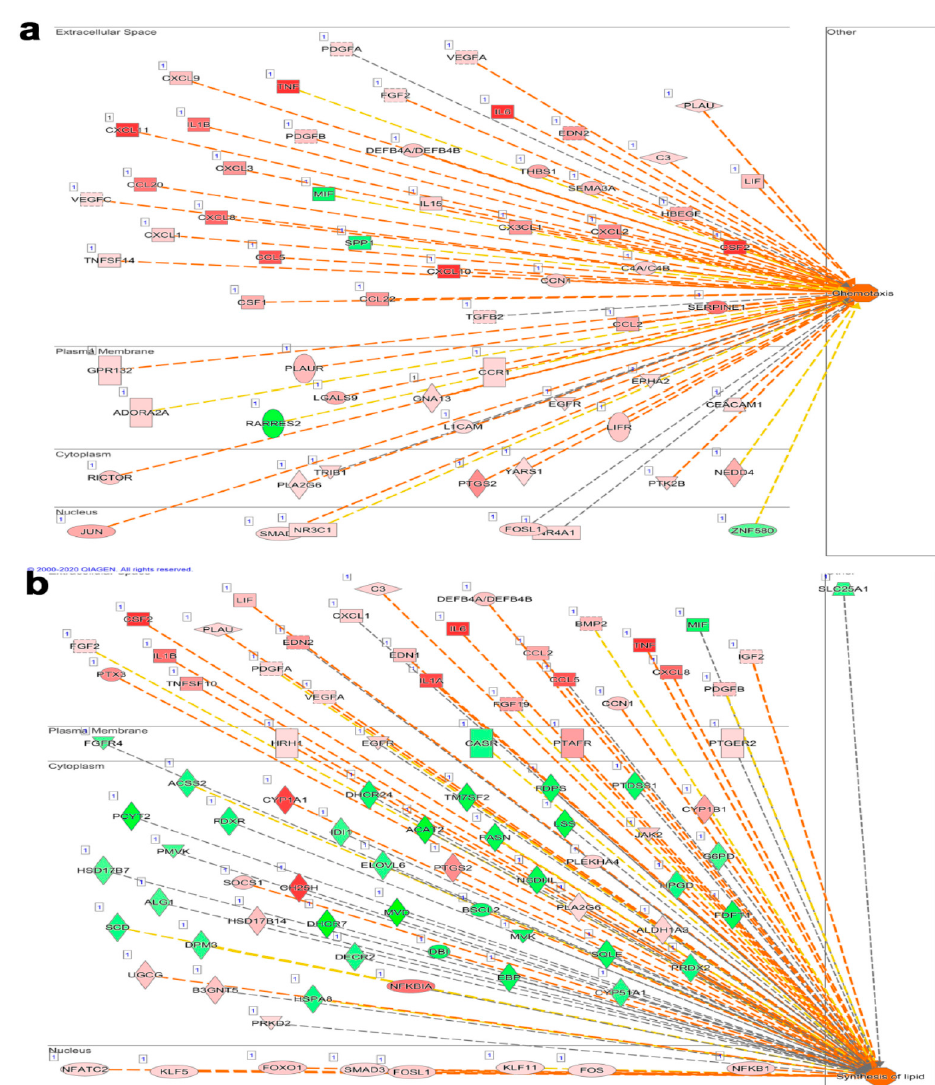
Figure 7. Activation of chemotaxis and synthesis of lipids functional categories in SARS-CoV-2-infected Calu-3 cells. Illustration of enriched chemotaxis ( a ) and fatty acid synthesis ( b ) functional categories in SARS-CoV-2-infected Calu-3 cells. Genes within the network, their interaction state, as well as their subcellular localizing based on IPA are indicated.